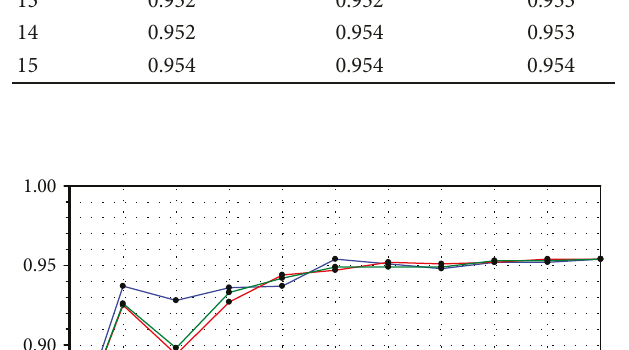
n . Red: α k , S 4,3